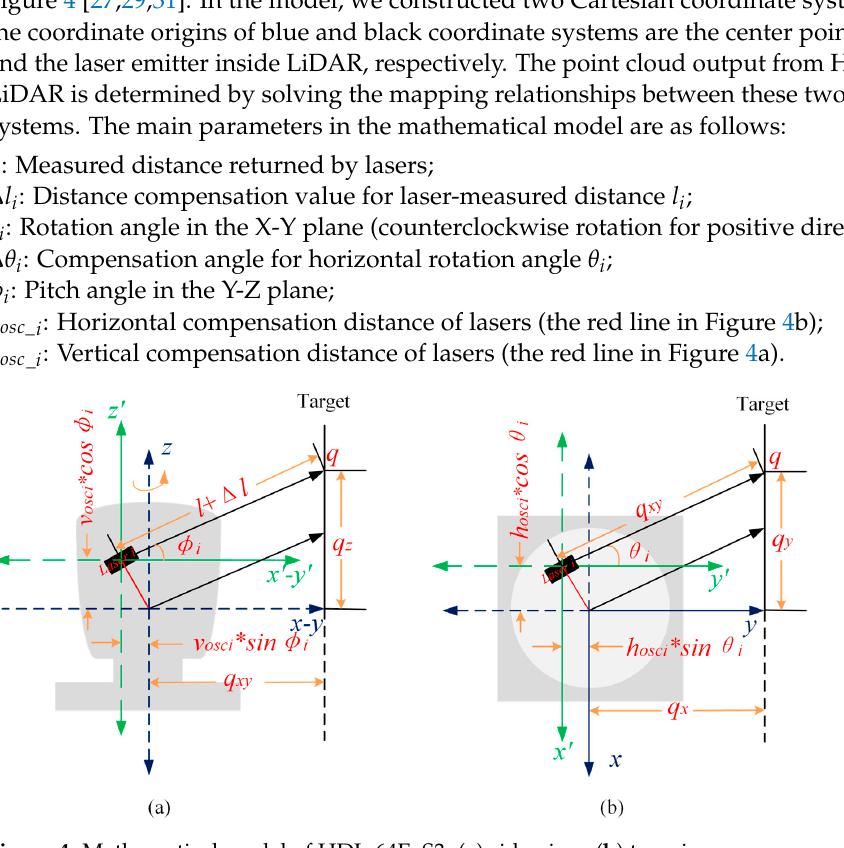
Figure 4. Mathematical model of HDL-64E_S3: ( a ) side view; ( b ) top view. Here, the letter i is the serial number of laser emitters; l i + ∆ l i and θ i + ∆ θ i are the actual distance and actual rotation angle collected by lasers,